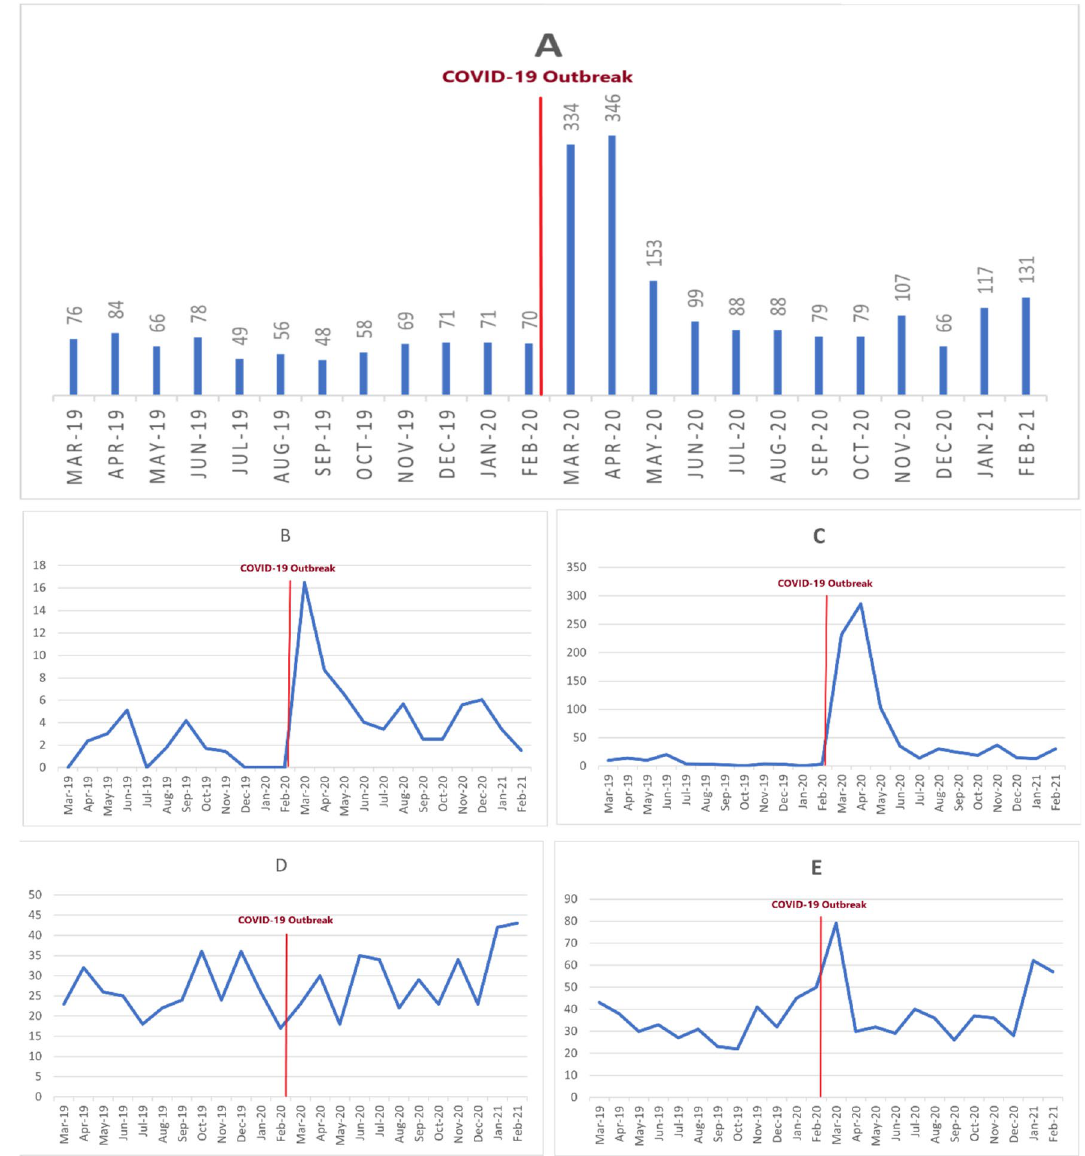
Figure 1. The trend of alcohol intoxication in the population: ( A ) all alcohols, ( B ) trend of mortality, ( C ) methanol, ( D ) co-ingestions, E